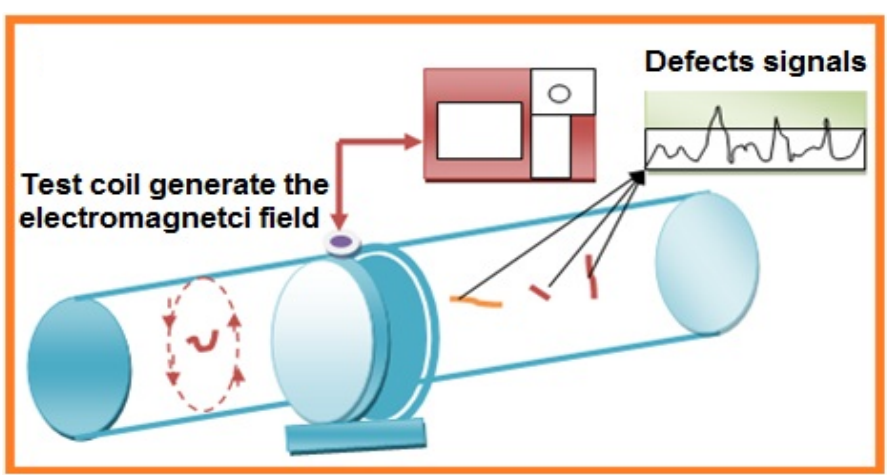
Figure 9. Schematic representation of experimental setup of Eddy current testing.